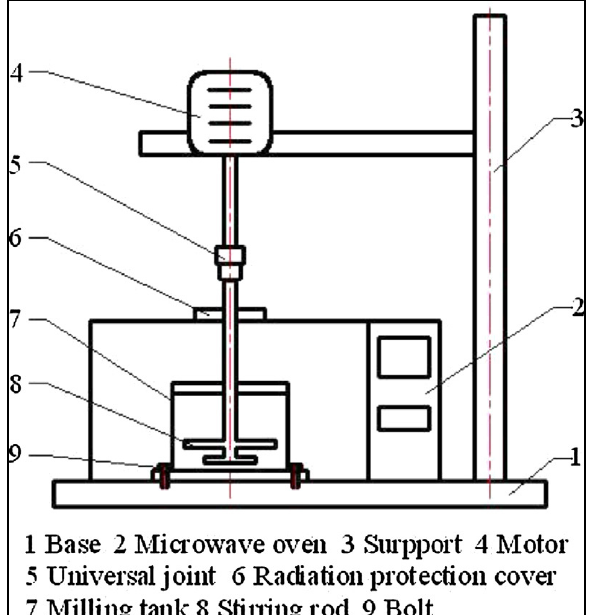
Figure 3. Schematic of Microwave-Assisted Ball Milling. “Reprinted/adapted with permission from